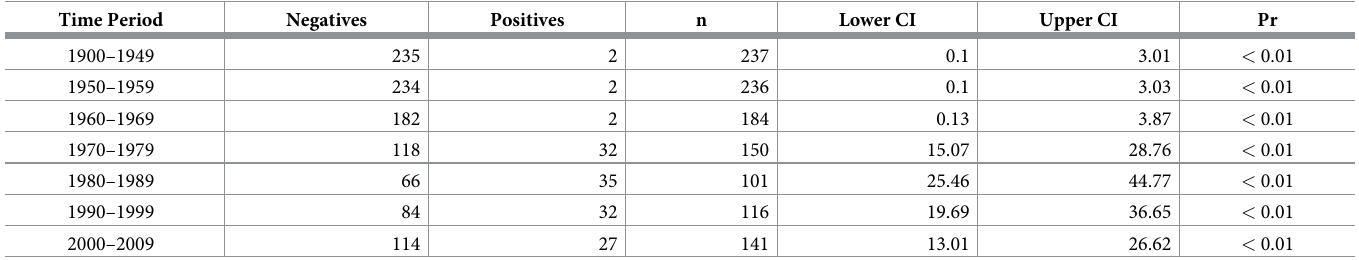
Table 1. Sample size per decade and the probability of detecting no Bd based on a 5% conservative probability of Bd detection. Credible intervals (CI) were calculated using binomial confidence